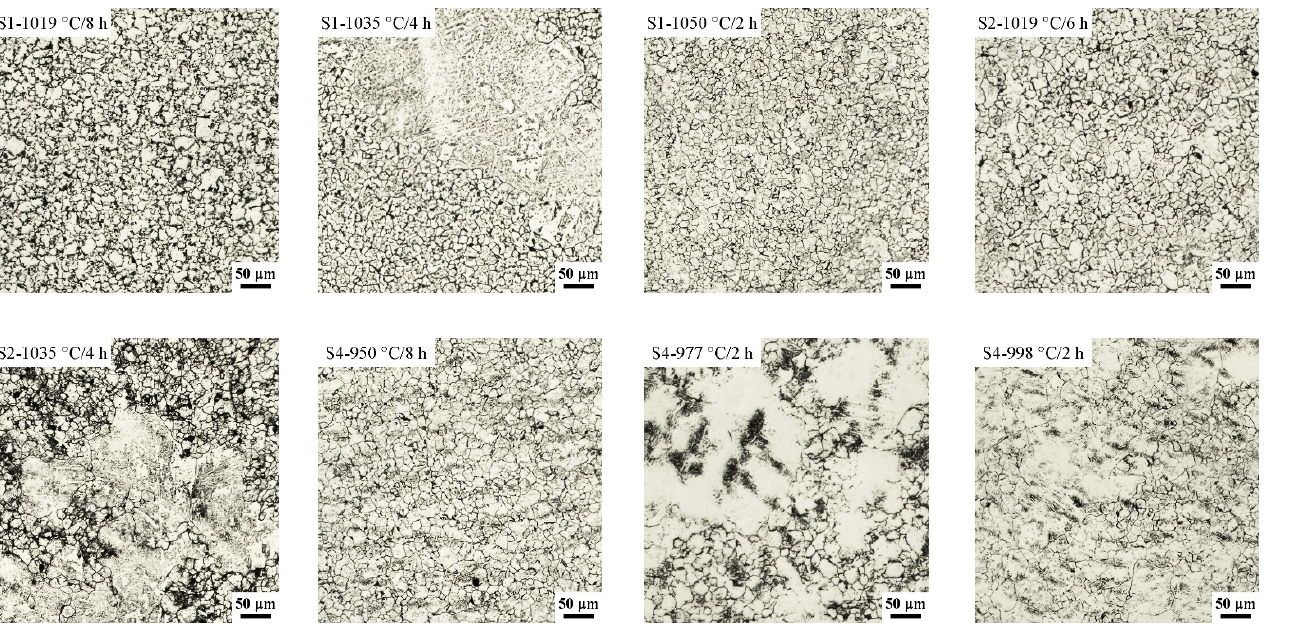
Figure 13. Several PAGSs of the verified experiments.